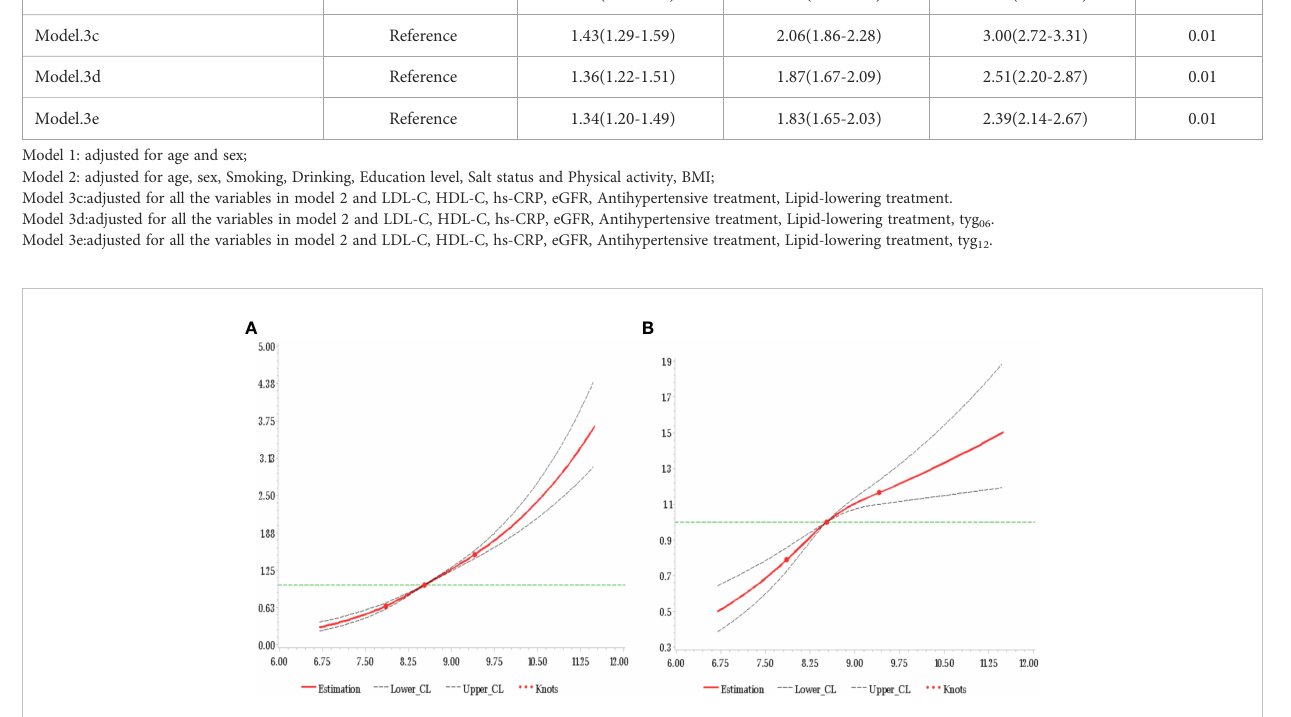
FIGURE 2 HR of CMDs and TyG-index at baseline adjusted for all covariates (A) and additional adjustment for average TyG-index up to baseline (B)